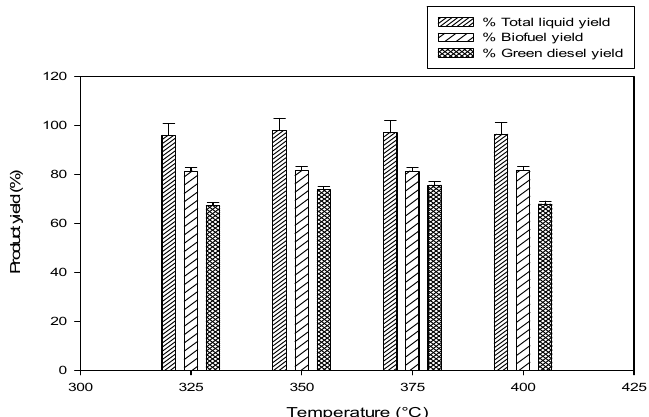
Figure 3. Effect of reaction temperature on production yield (%) during hydrotreating reaction of RBO.